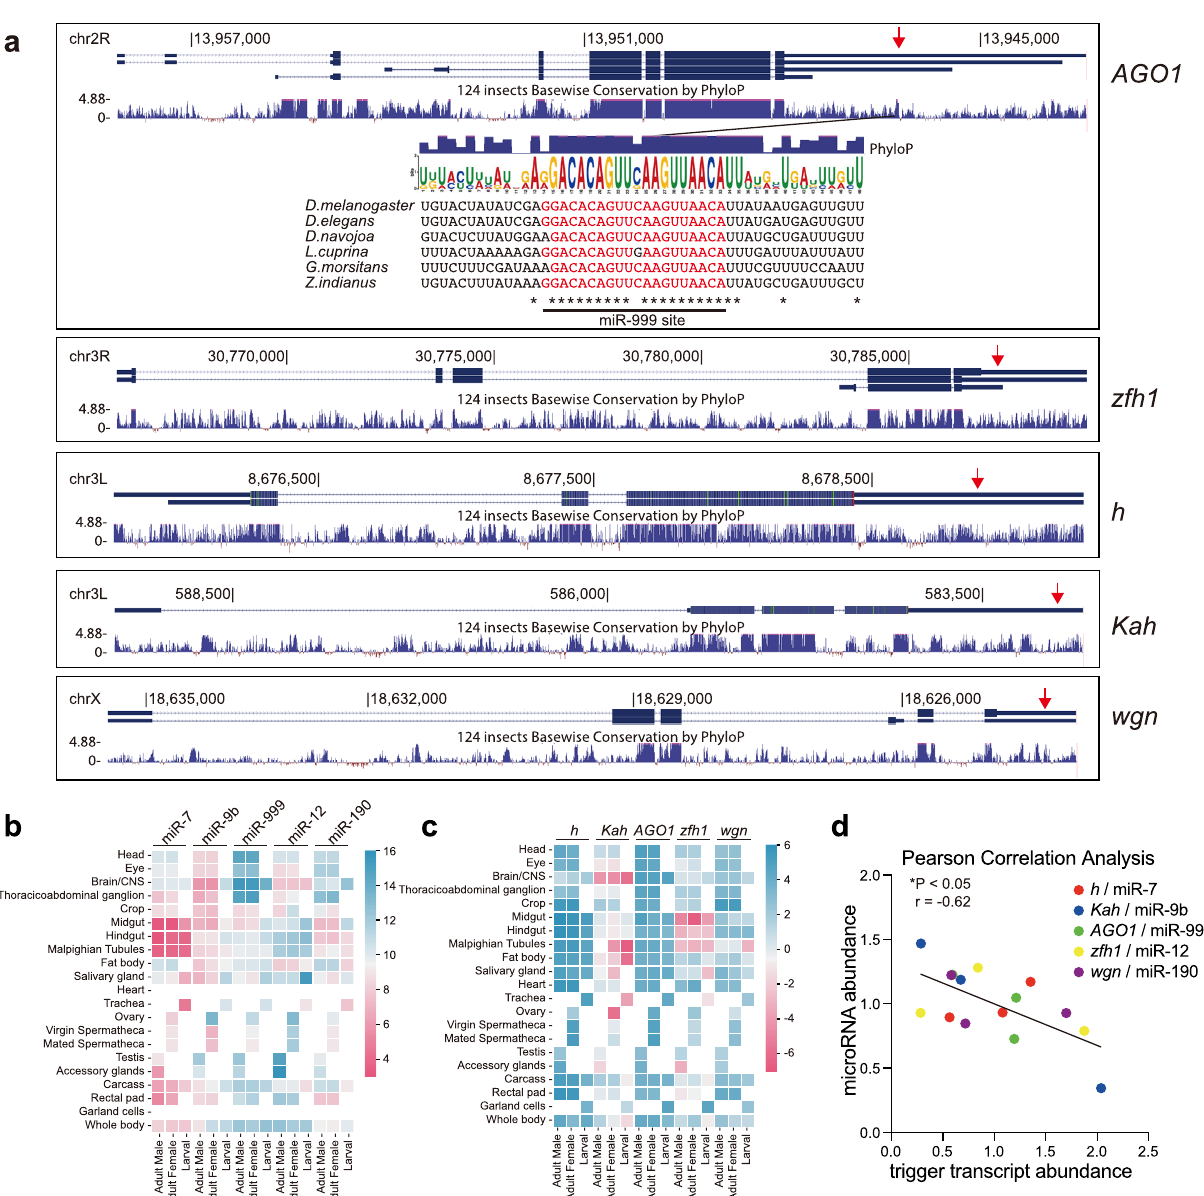
examples.Tissue-speci fi cmiRNAabundance( b ) and triggertranscripts abundance ( c ) in Drosophila from FlyAtlas 2. The gene abundance scale (log 2 FPKM for genes, log 2 RPM for miRNA) is shown as heatmap on the right. d Negative correlation between the miRNA abundance and trigger transcript abundance in Drosophila whole body. The linear regression is shown with solid line. r, pearson correlation coef fi cient. P =0.0153<0.05 by two-tailed test. Source data are provided as a Source Data fi